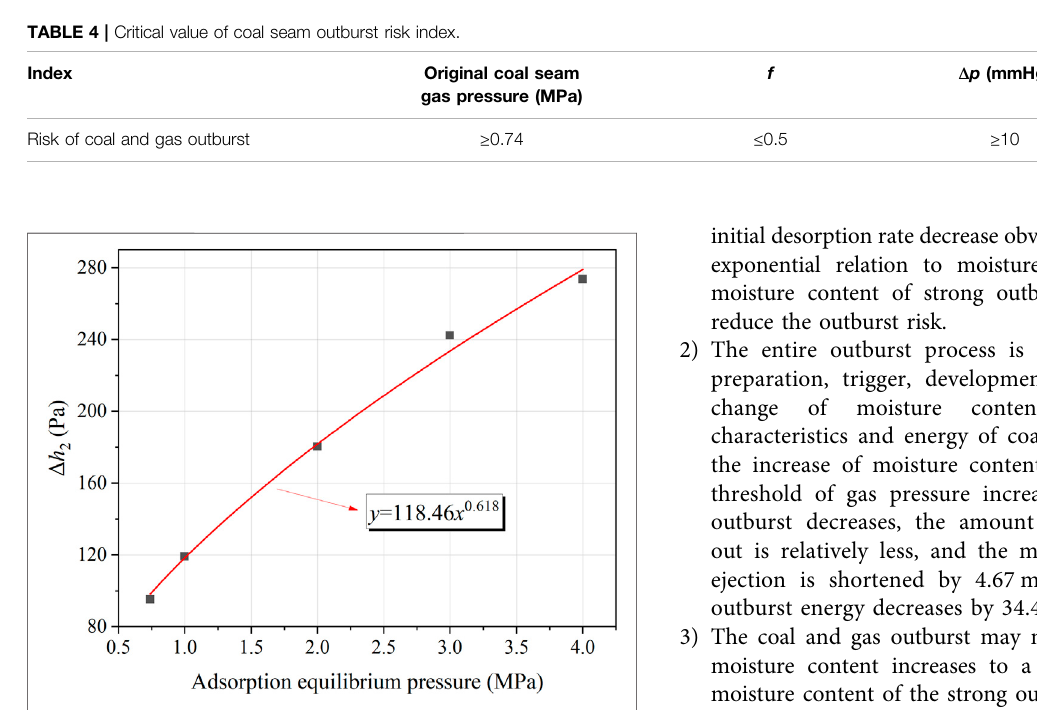
FIGURE 11 | Fitting curve of adsorption equilibrium pressure effect on the Δ h 2 of coal with 5.19% moisture content.